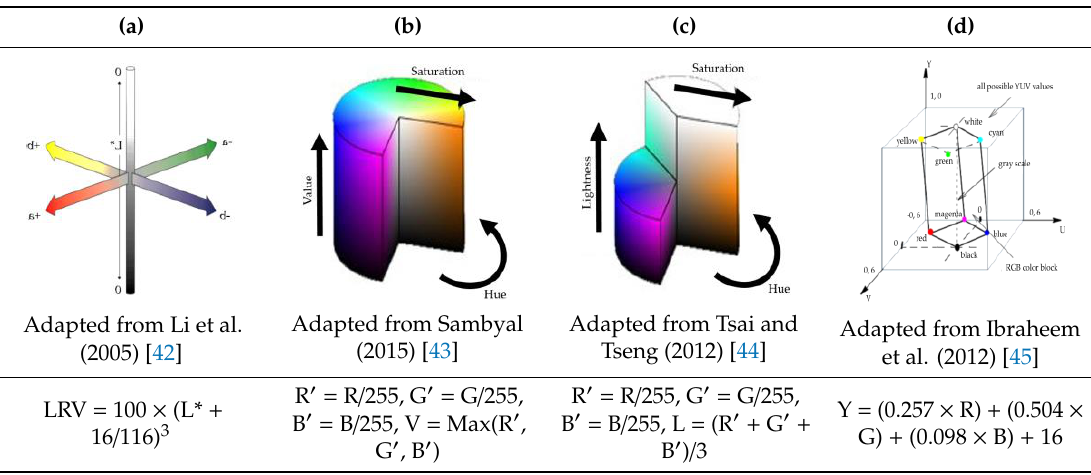
Table 3. Values of the color space technology (i.e., light-reflectance value (LRV), hue saturation value (HSV), hue saturation lightness (HSL), and YUV), surface temperature, and indoor temperature according to color.